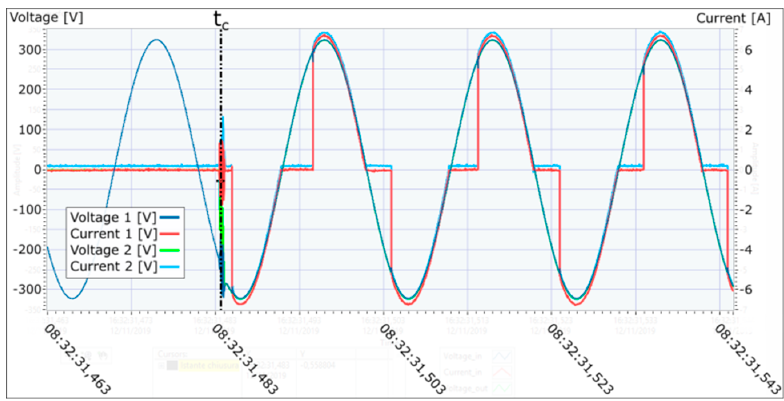
Figure 21. Instant ( t s ) when the current began to flow only in the positive half-waves (using the Bourns 2049-25 surge arrester).